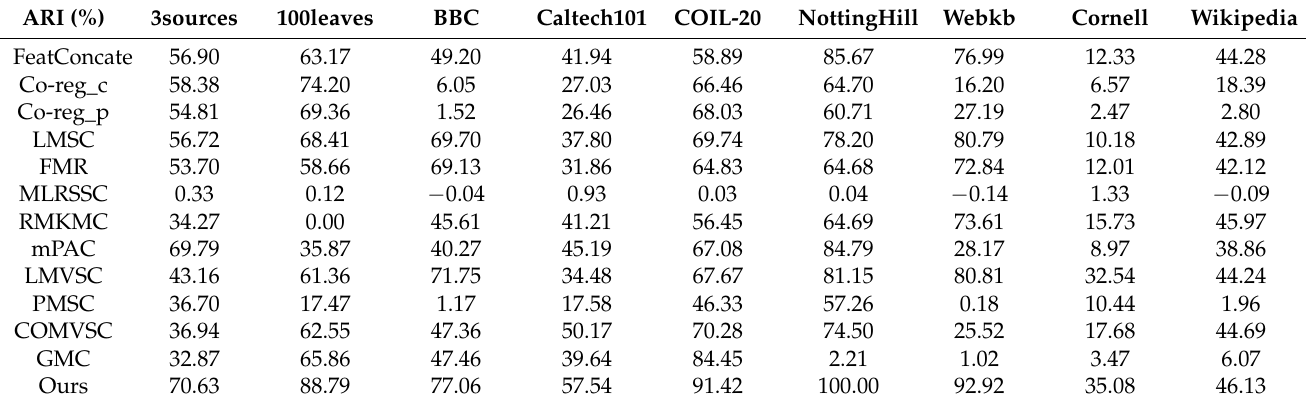
Table 6. The clustering performance comparison in terms of ARI on nine multi-view data